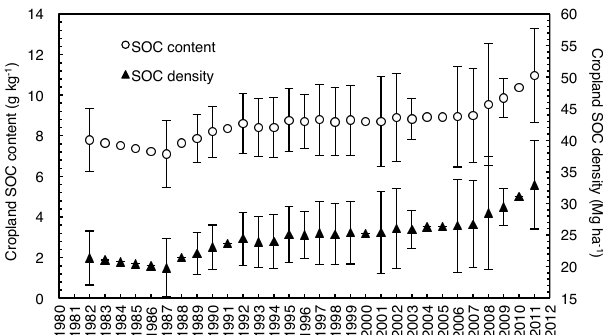
Figure 1. Evolution of SOC content and density for cropland from 1982 to 2011 in Huantai County. Error bars are shown only for the years which soil survey is